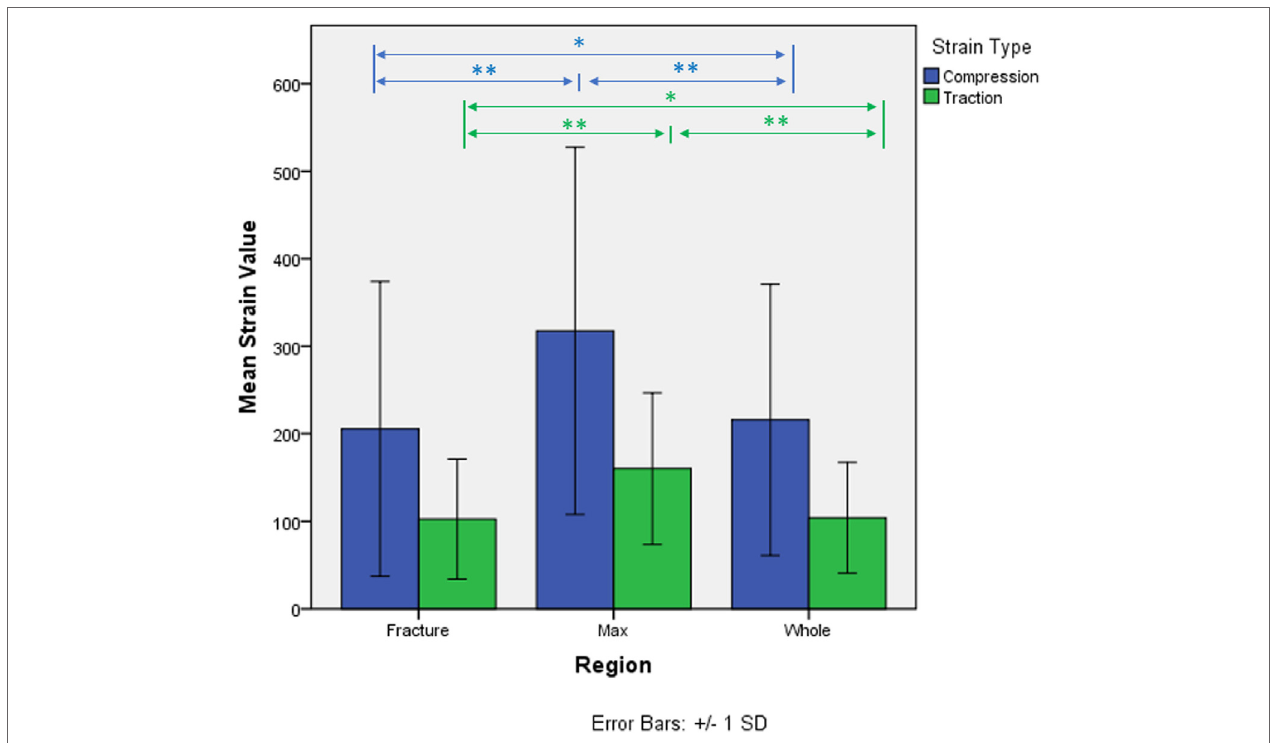
FigUre 4 | Micro-strains in compression and traction in the three identified regions of analysis. * p -value < 0.05. ** p -value <